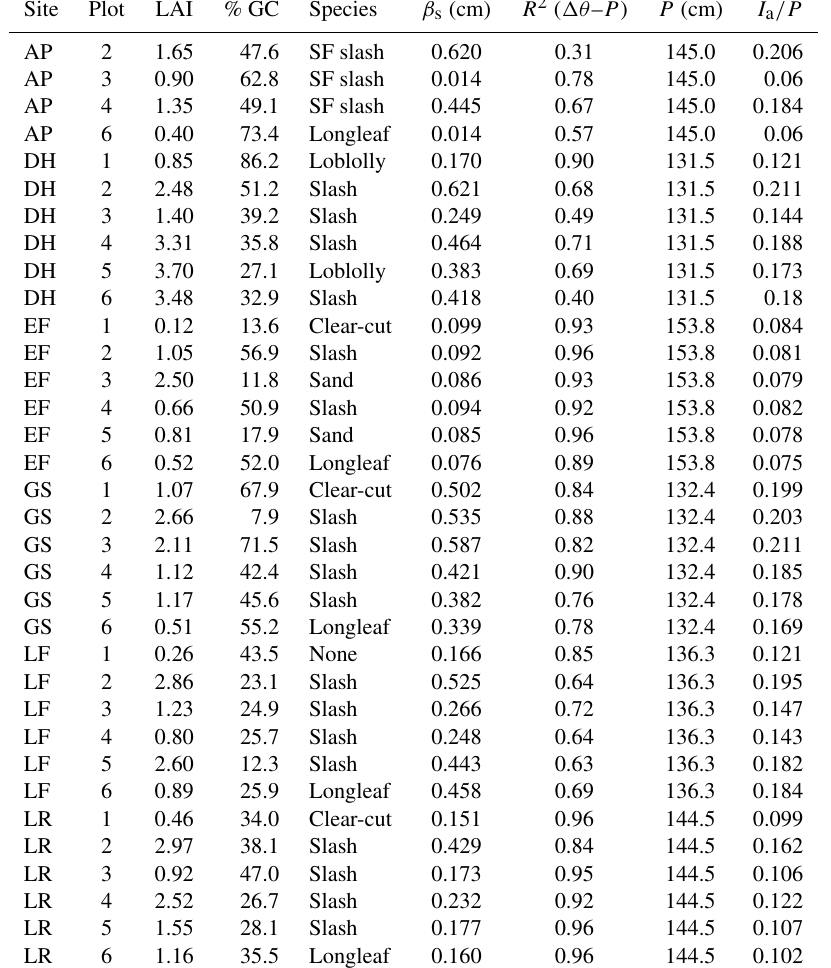
Table 1. Summary of storage capacity ( β s ) and annual interception losses ( I a ) for all sites and plots, along with plot characteristics (mean annual precipitation, P ; leaf area index, LAI; percent ground cover, % GC; and species). Note that the AP site only had four plots with the data required for the